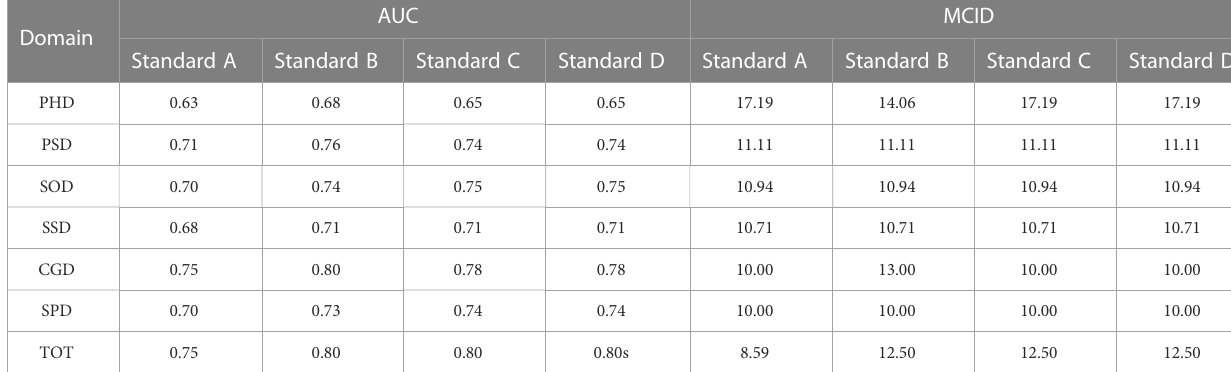
TABLE 3 The MCID of QLICP-BR (V2.0) determined by ROC curve method under different standards ( n A =182, n B =232, n C =156, n D =202).